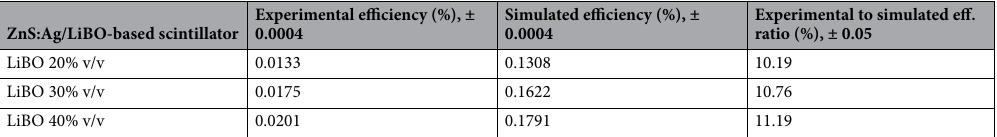
ZnS:Ag/LiBO-based scintillator